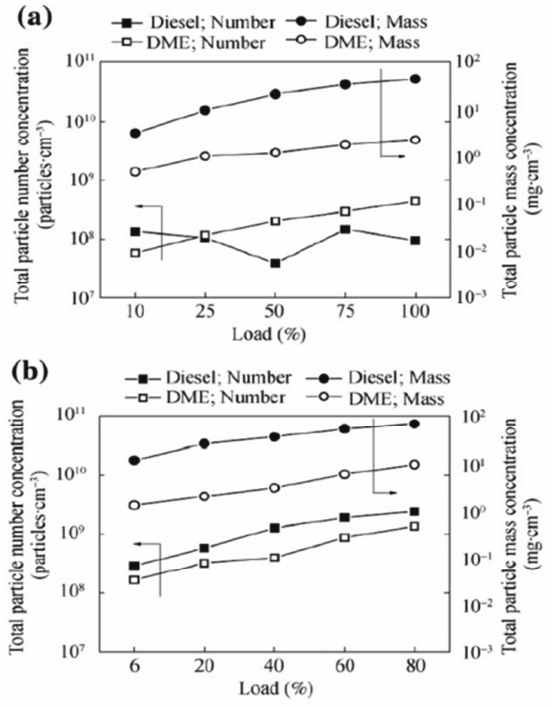
Fig. 6. The influence of the engine load and speed on the exhaust particle number and mass concentration for DME and diesel fueled engines; (a)